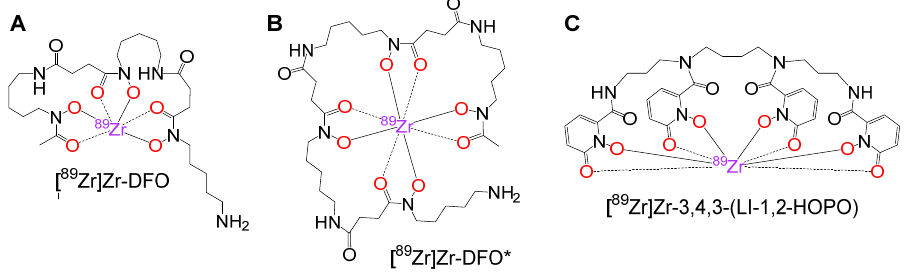
Figure 1. Structures of [ 89 Zr]Zr-DFO ( A ), [ 89 Zr]Zr-DFO* ( B ) and [ 89 Zr]Zr-3,4,3-(LI-1,2-HOPO) ( C ).